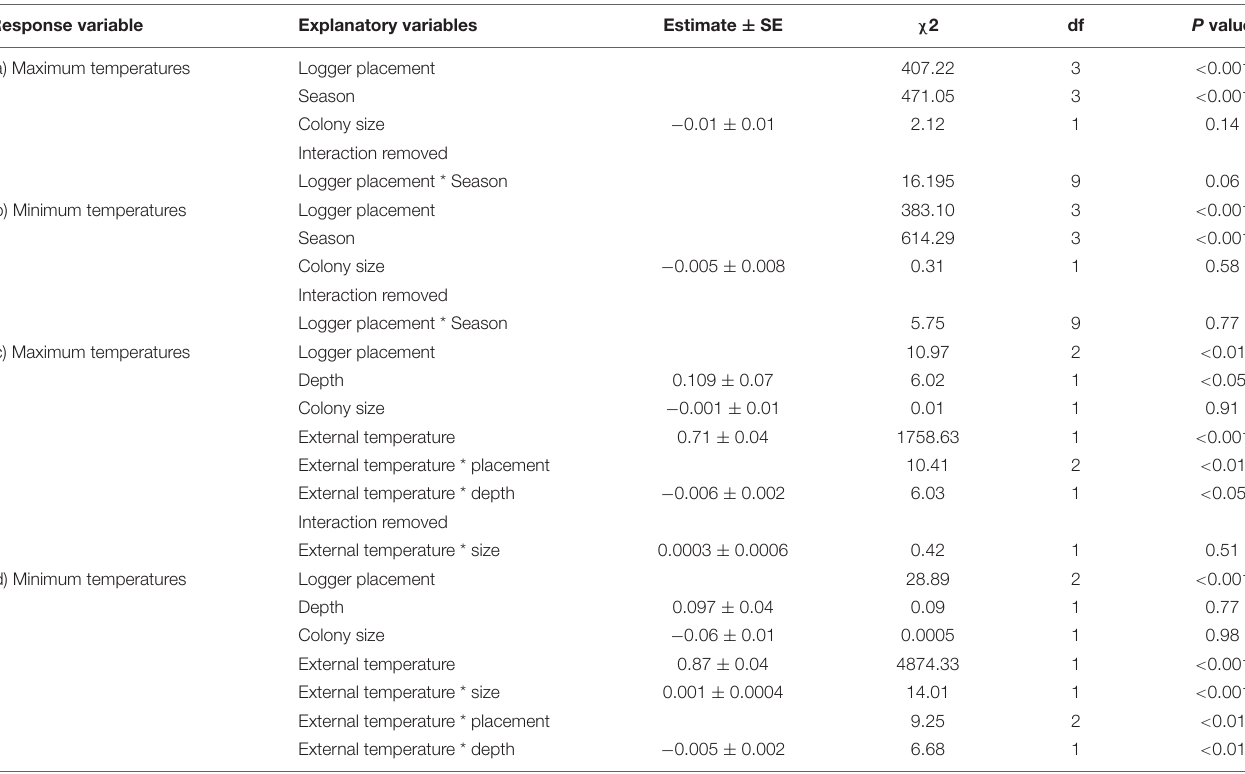
TABLE A1 | Linear mixed models investigating the maximum and minimum temperature variables to logger placement, season, and colony size.